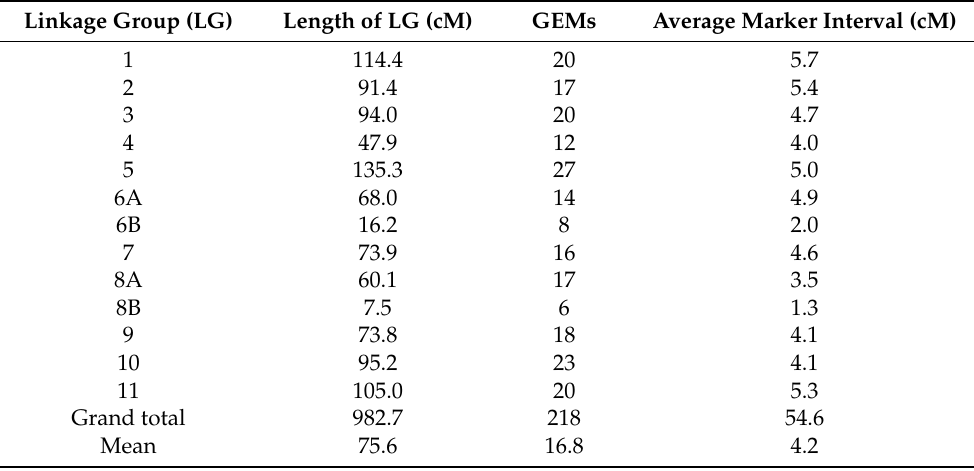
Table 2. The distribution of gene expression markers (GEMs) across 13 LGs for genetic linkage analysis in the F 5 segregating population of bambara groundnut. Linkage Group (LG) Length of LG